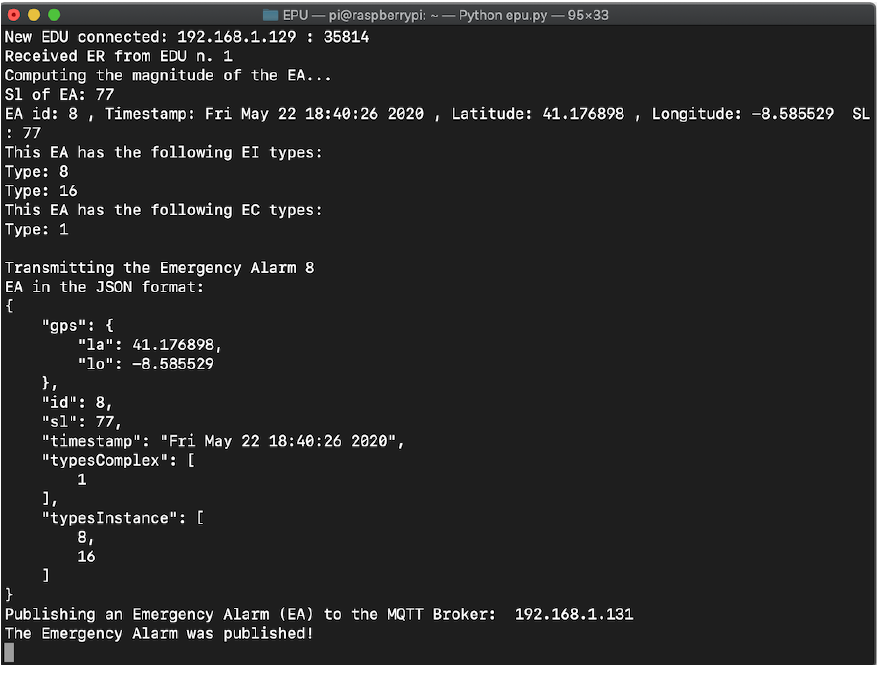
Figure 8. An example of interaction with the